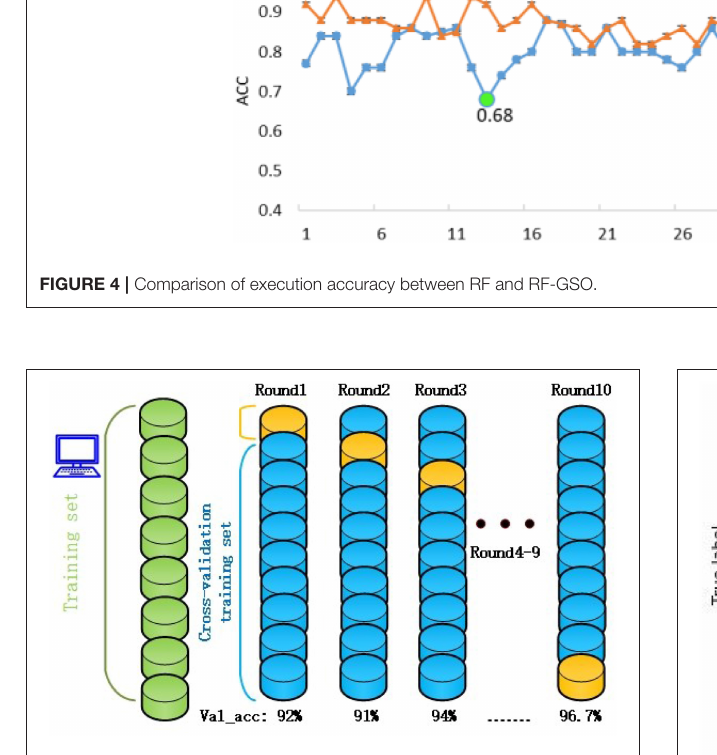
FIGURE 5 | The accuracy of RF-GSO model under 10-fold CV.